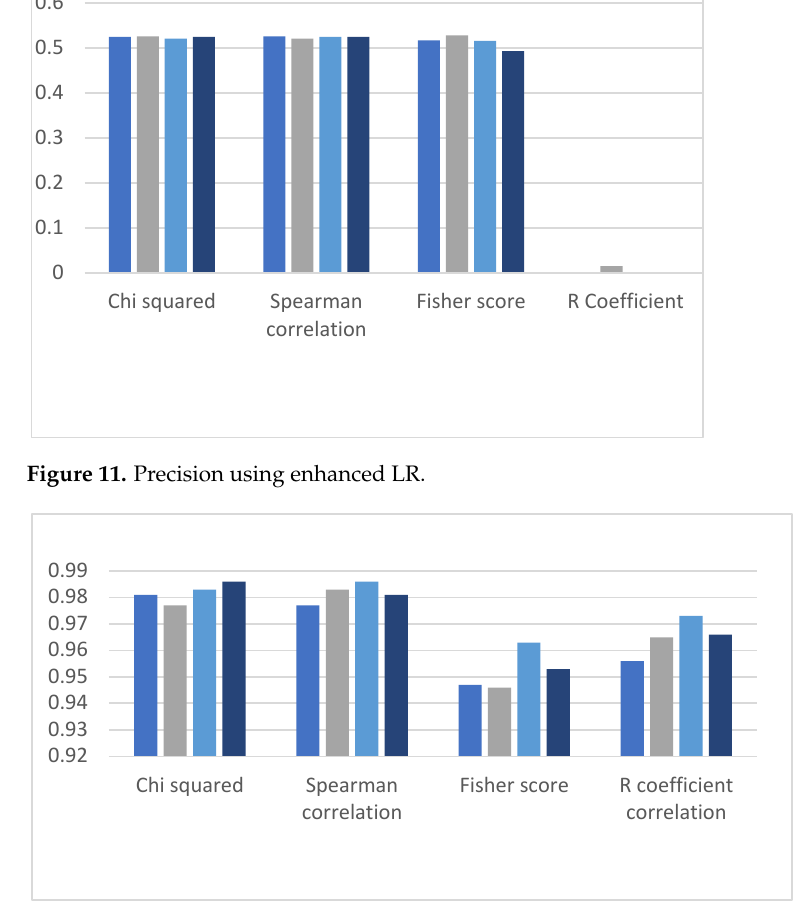
Figure 12. Accuracy using enhanced decision forest.